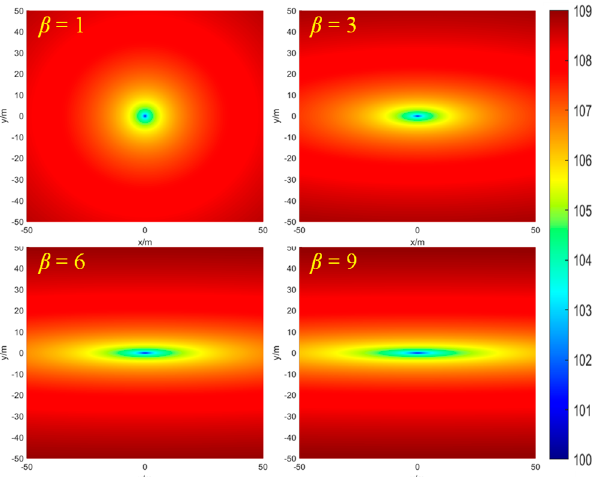
Figure 4. Distribution of pressure field in homogeneous and heterogeneous coal seams without fracturing.